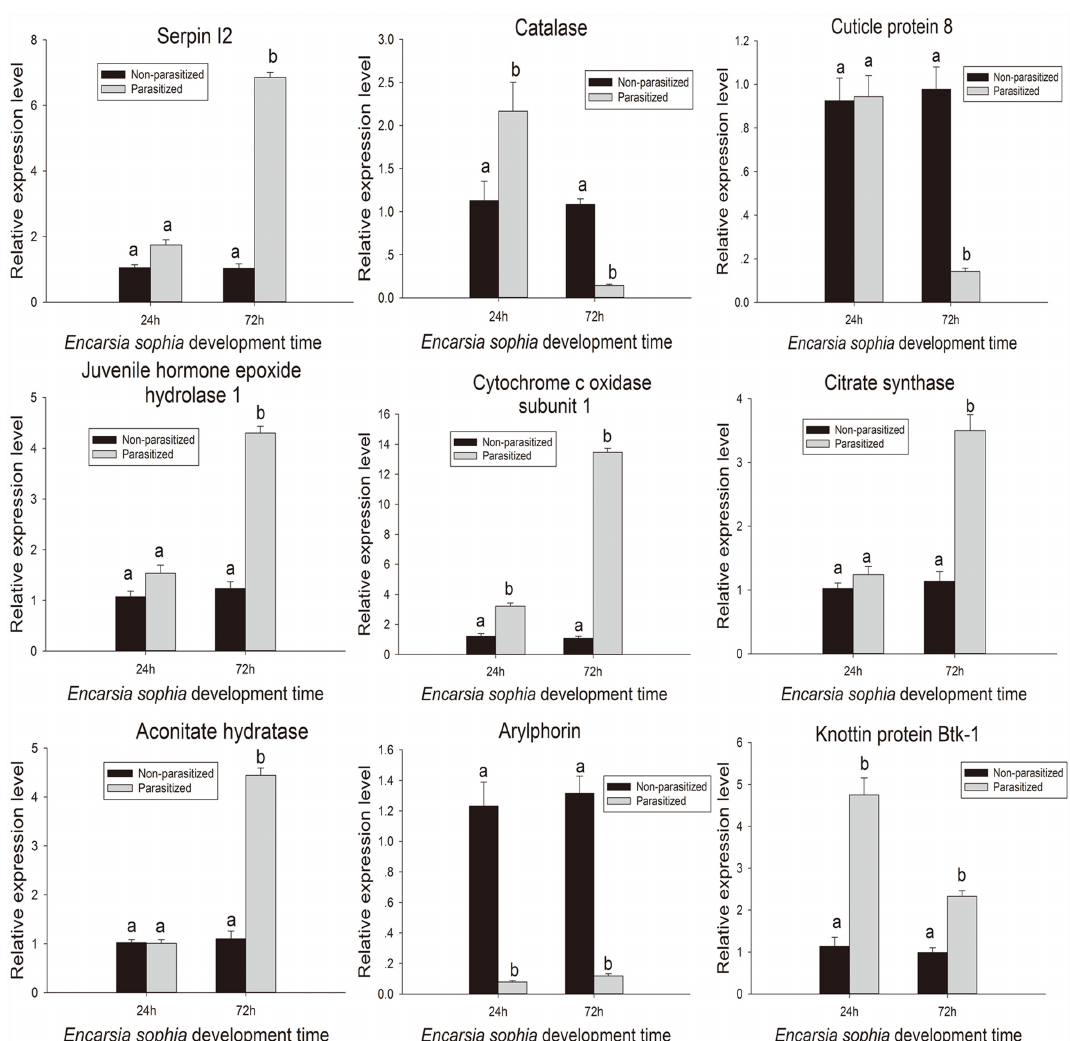
Fig 4. A qRT-PCR analysis of nine randomly selected genes from B . tabaci that showed relative expressions at 24AP and 72AP. Black stands for the control and gray stands for a parasitized sample. The expression levels of the controls were regarded as 1. Error bars indicate standard deviations of the average from three replicates. The same letter above the error bar means that there was no significant difference at the 0.05 level by Duncan ’ s